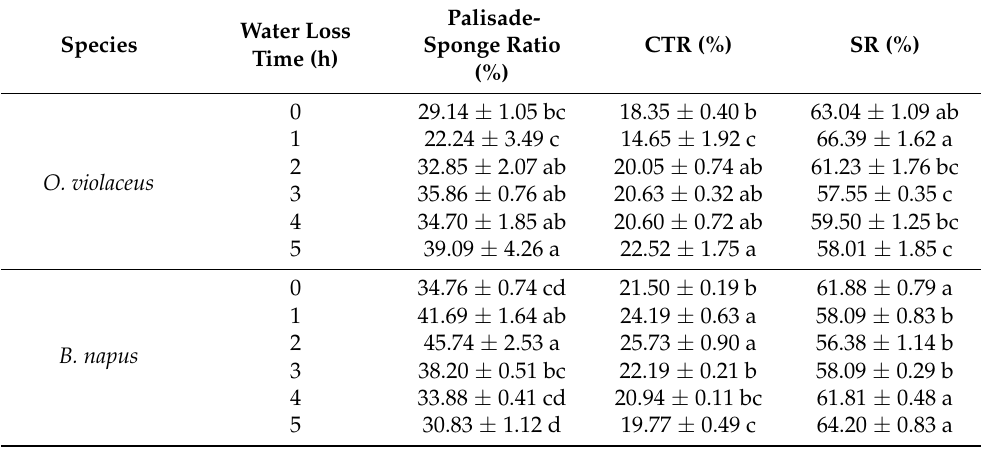
Table 4. Comparison of leaf tissue characteristics between O. violaceus and B. napus .